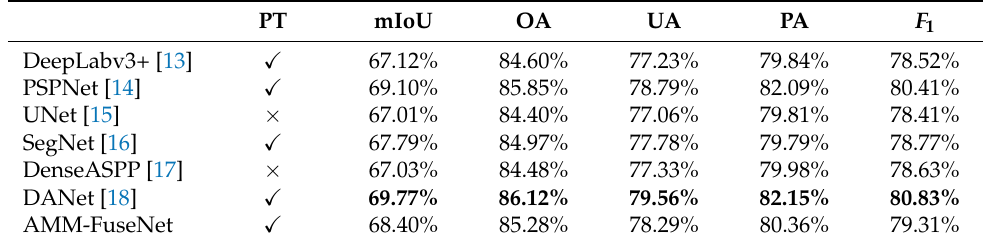
Table 9. Performance comparison for Potsdam dataset. ( (cid:88) : pre-trained (PT) and × : not PT